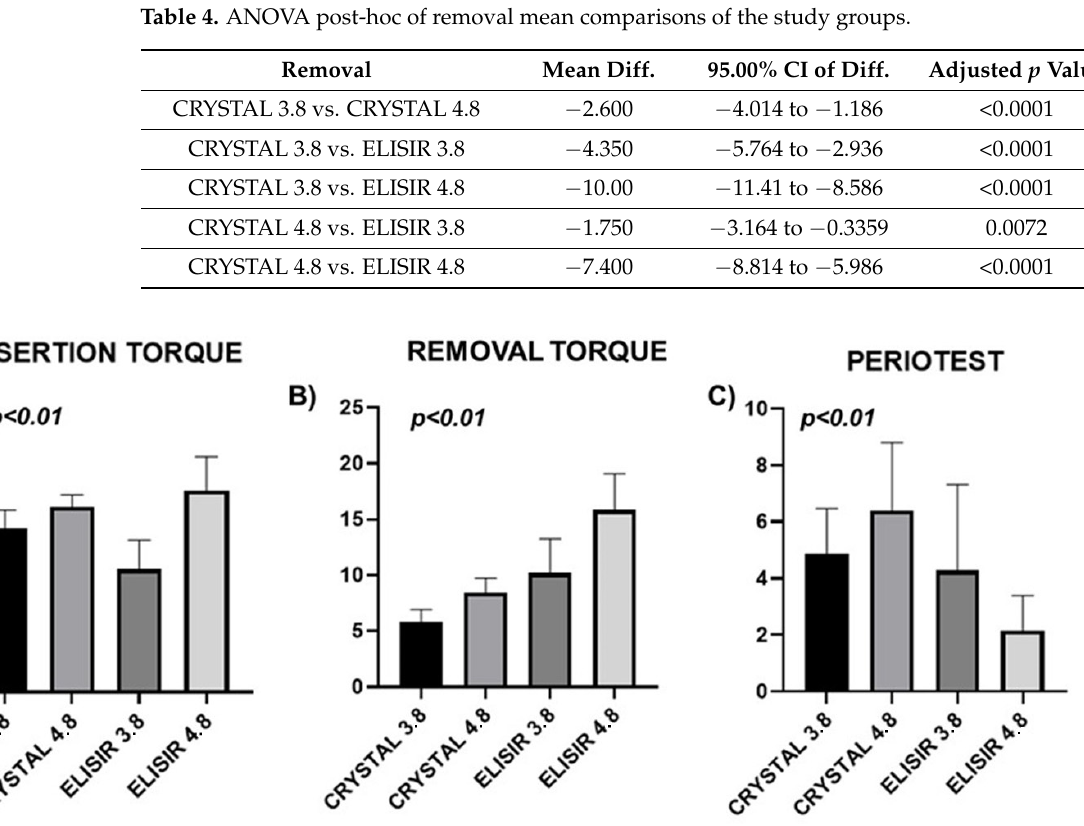
. Figure 5. Detail of the Bland–Altman plot of the Periotest assessment. 4. Discussion The vital bone represents a dynamic tissue in constant physiological remodelling as a consequence of the external stimuli and function [29–32]. As a consequence of the loss of function, the edentulism often determines not only a decrease in ridge volume, but also a decrement of bone quality and density [33–36]. A greater component of alveolar cancellous bone, instead of poor cortical bone, is clinically associated with increased difficulty to obtain sufficient implant stability and os- seointegration [37]. This research investigation has been focusing on the mechanical fea-